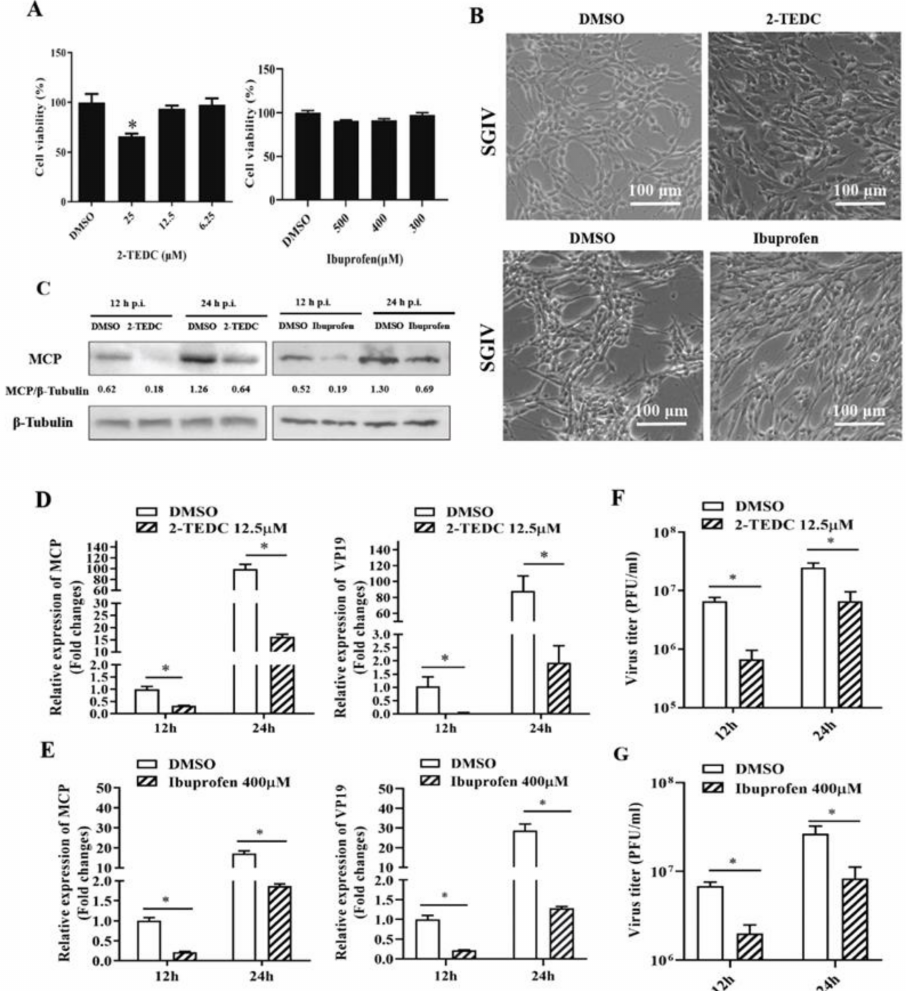
Figure 6. The roles of AA metabolism during SGIV replication. ( A ) The cytotoxicity of 2-TEDC or Ibuprofen on GS cells was determined using MTT assay. ( B ) The severity of CPE induced by SGIV infection at 24 h p.i. in 2-TEDC or Ibuprofen-treated cells. ( C ) Western blotting analysis of viral MCP during SGIV infection in 2-TEDC or Ibuprofen-treated cells. ( D , E ) The viral gene transcription levels of SGIV, MCP, and VP19 were detected in infected cells after treatment with 2-TEDC or Ibuprofen by qPCR, respectively. ( F , G ) The effects of 2-TEDC or Ibuprofen on virus titers during SGIV infection were detected by virus plaque assay. Data are expressed as means ± SD. The asterisks (*) indicated p <